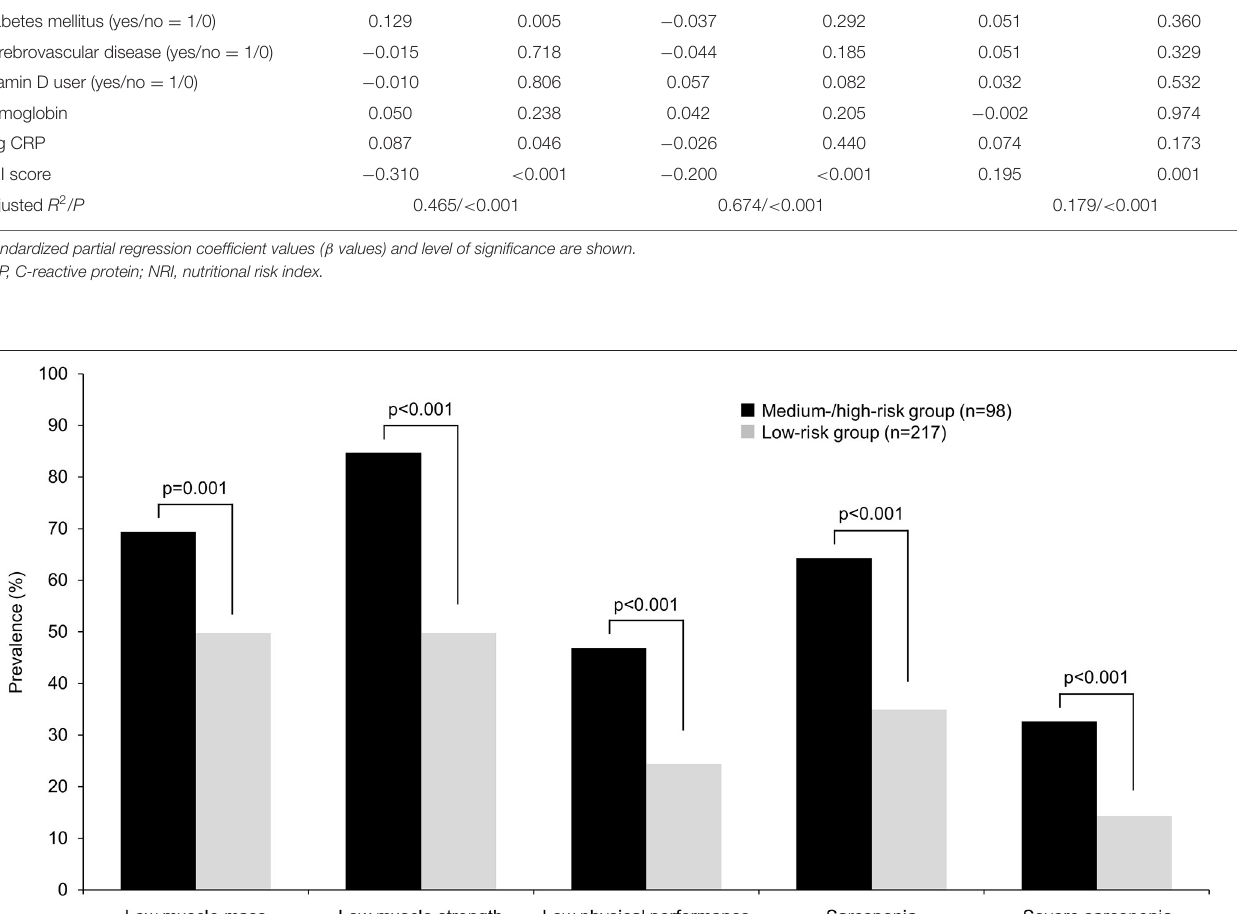
presence of medium- or high-risk, medium-/high-risk status retained a significant association with low muscle mass